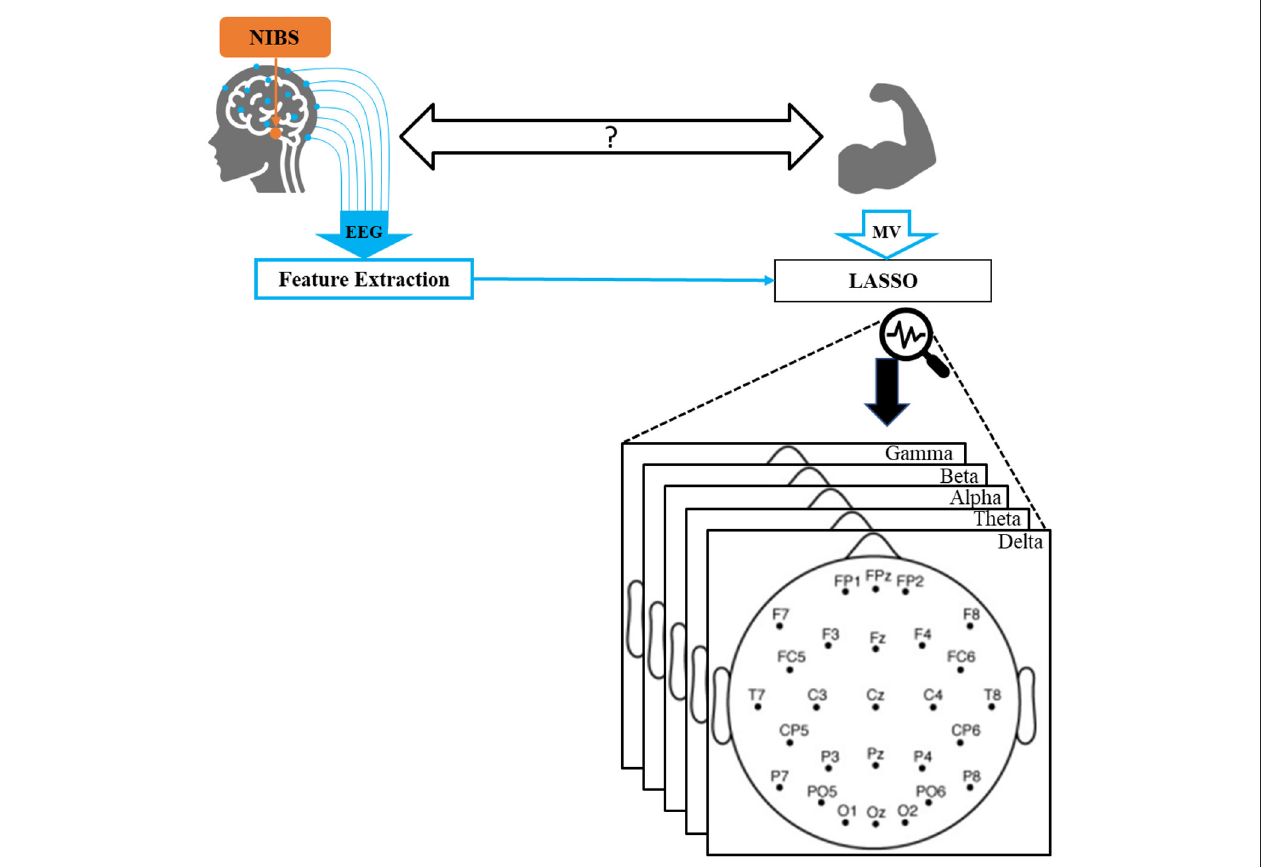
FIGURE 1 | Overall schematic of our proposed method. EEG and motor vigor data were collected while participants received non-invasive brain stimulation. A comprehensive set of standard features were extracted from EEG. Utilizing LASSO, MV was predicted by a subset of features, which were finally projected back into the EEG spectral and spatial